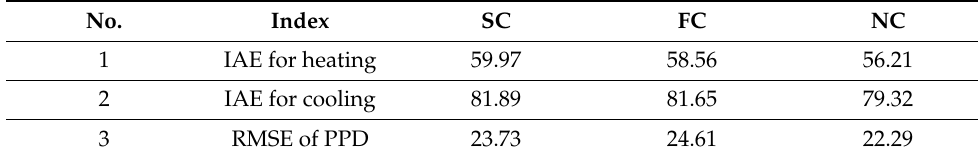
Table 2. Comparison of control accuracy by three controllers.